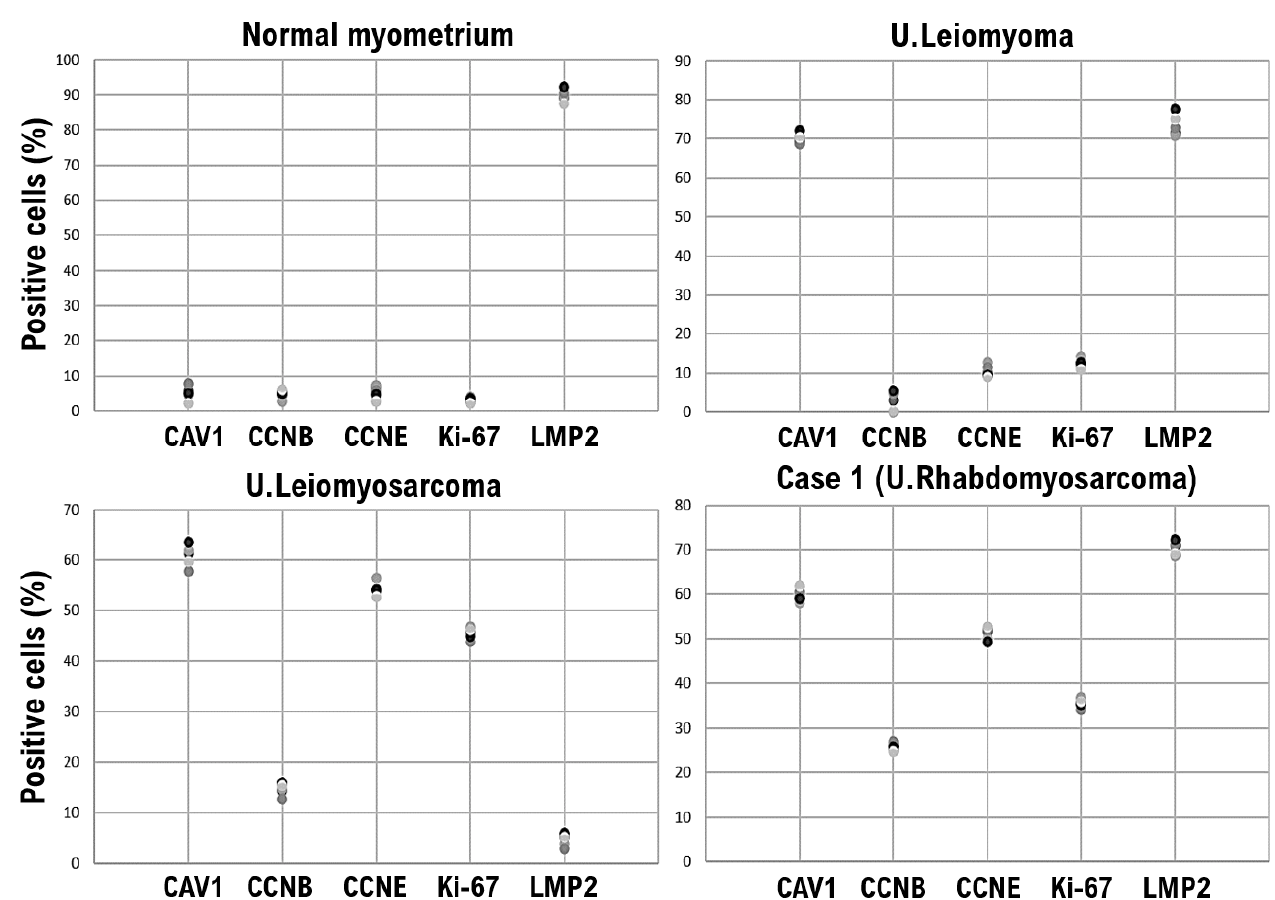
Figure 2. Significance of LMP2/b1i-positive uterine mesenchymal tumor cells in the Case 1 tumor as well as normal myometrium and uterine leiomyoma. Immunohistochemistry of normal myometrium, uterine leiomyoma, uterine leiomyosarcoma, and Case 1 uterine tumor tissues was performed using appropriate monoclonal antibodies. The tissues were randomly selected from normal myometrium, uterine leiomyoma, uterine leiomyosarcoma, and the Case 1 uterine tumor. Under a 40 × field of view, the positive rates for five biomarkers were determined in four tissue sites under a microscope (Panthera Shimadzu Co. Ltd., Kyoto, Japan). The positive rates at each site for each tissue are displayed in a scatter plot. CAV1, caveolin-1; CCNB, cyclin B; CCNE, cyclin E; LMP2, LMP2/ β 1i.